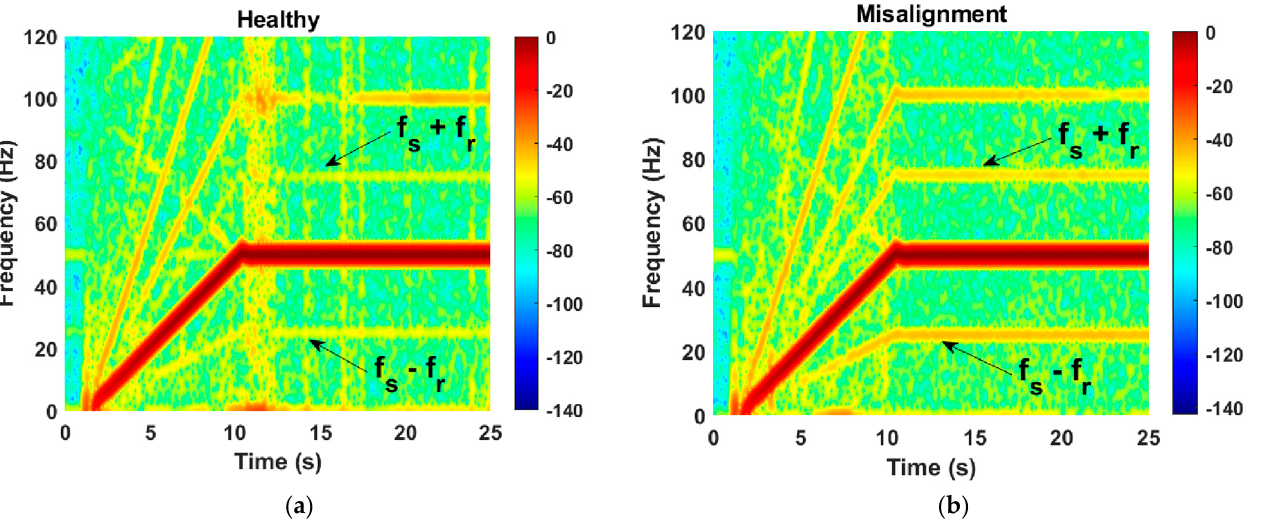
Figure 8. STFT analysis of SynRM, ( a ) Healthy motor and ( b ) motor with certain level of misalign- ment.